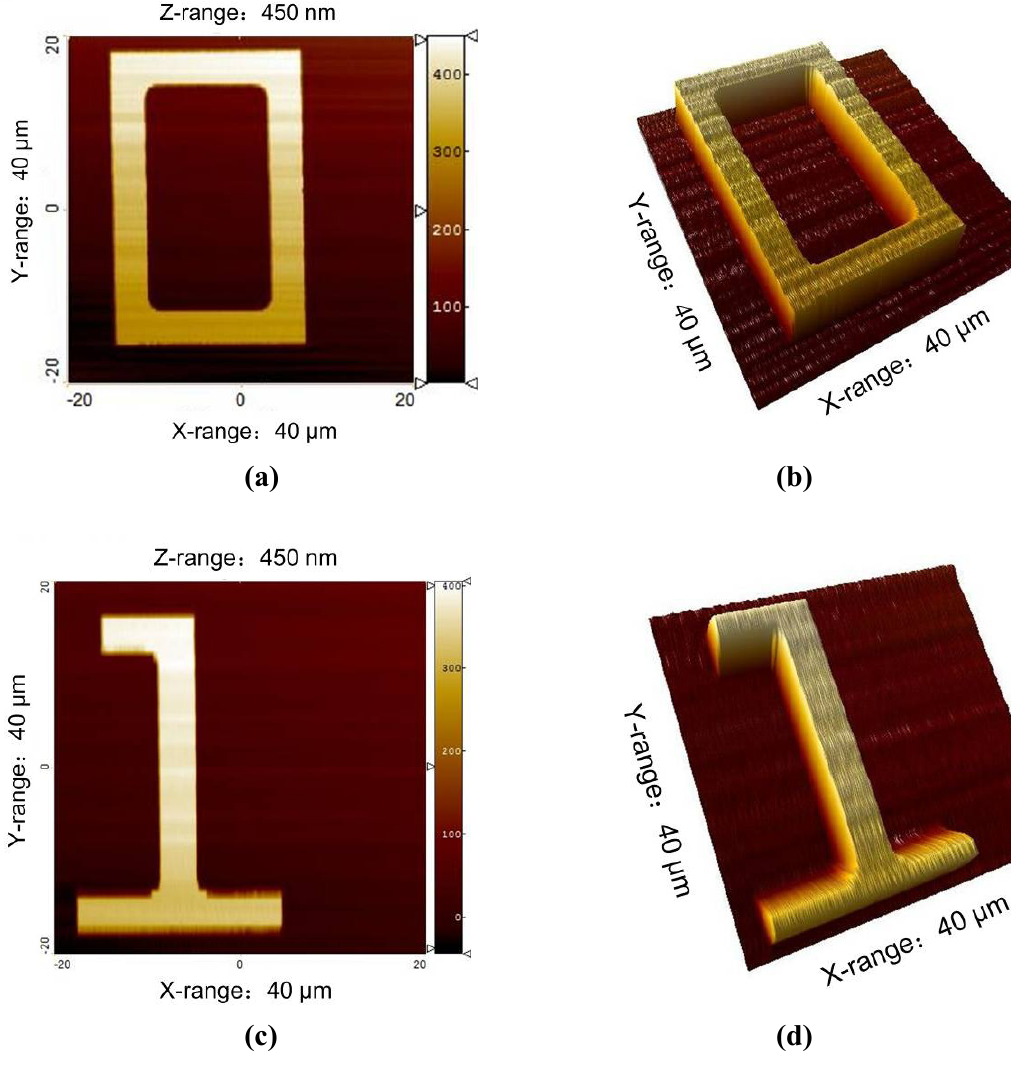
Figure 11. The measurement results of the ROI’s two regions by AFM: (a) and (c) are the two-dimensional images; (b) and (d) are the three-dimensional